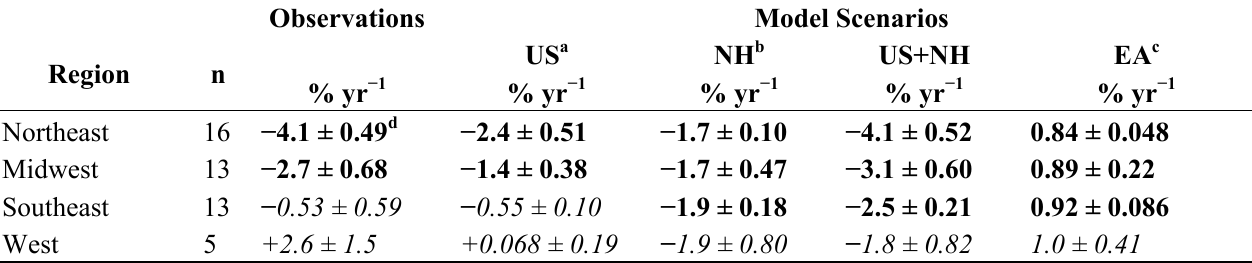
Table 3. Comparison between observed regional trends in VWM Hg concentrations (model subtraction approach) and three model simulations assuming changing emissions or background